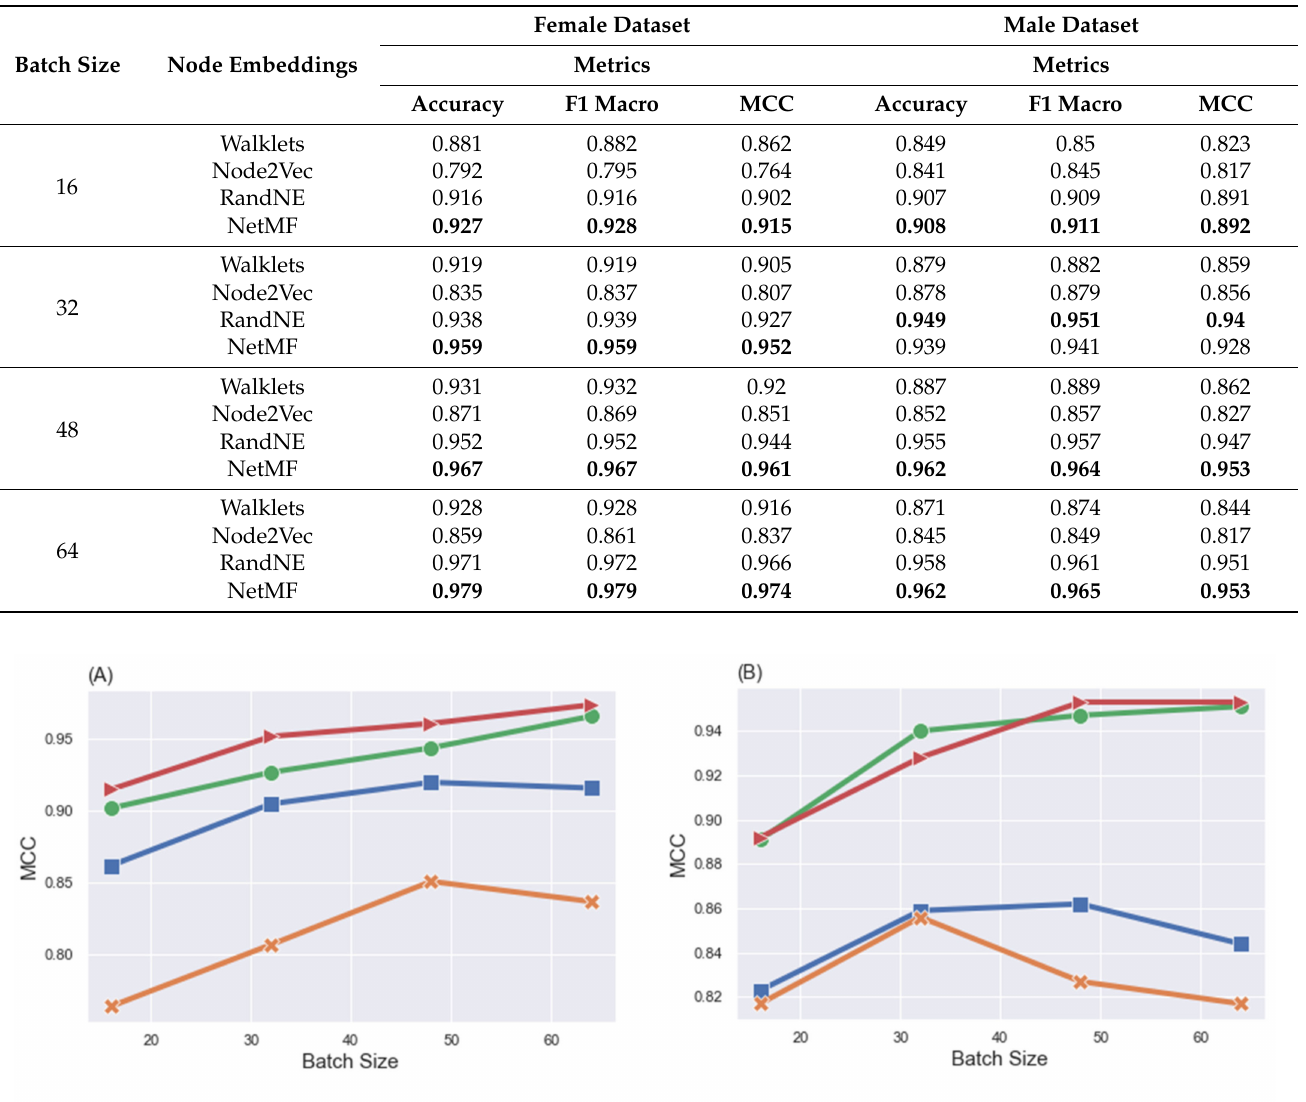
Table 3. Two-factor performance comparison, taking into account the influence of node embedding methods and batch sizes in the GCN model, by using both the female and the male fMRI data. Bold values represent the best classification performance obtained for each batch size.